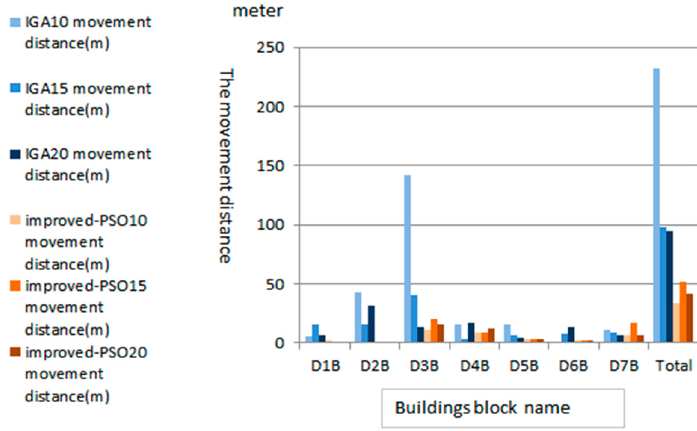
Figure 10. Displacement distance comparison graph (unit: meter).